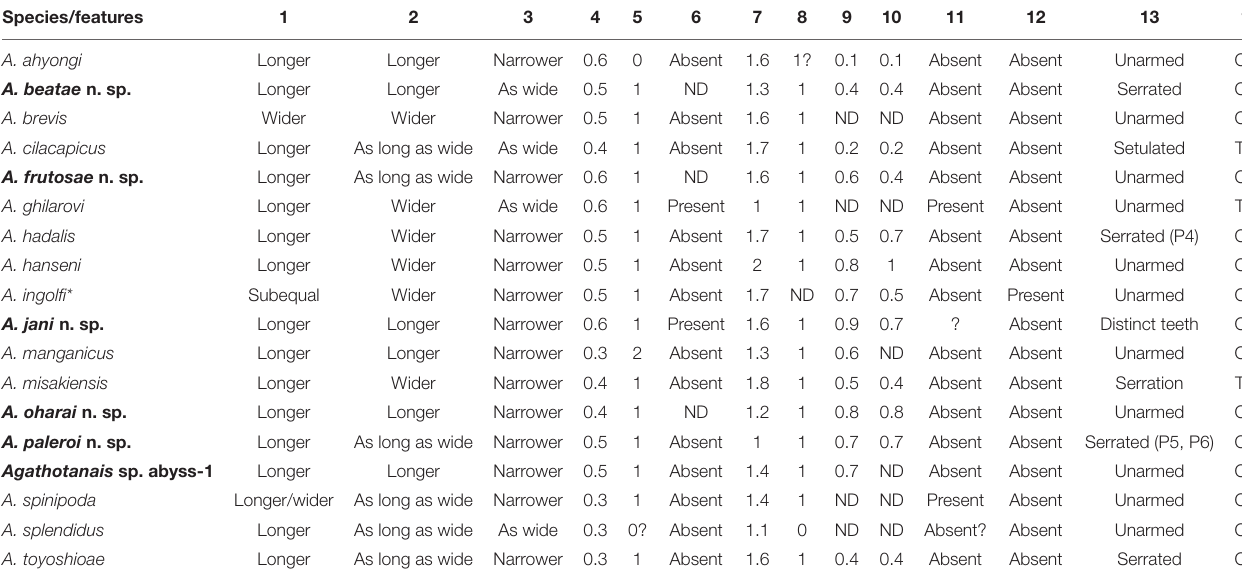
TABLE 1 | Diagnostic features distinguishing the species of Agathotanais : (1) Pereonites 4–5 L:W; (2) Pereonite-6 L:W; (3) Pleon: pereonite-6; (4) Antennule article-3:article-1; (5) Antenna numbers of articles; (6) Maxilliped endites distal denticles; (7) Cheliped palm L:W; (8) Fixed finger number of setae; (9) Pereopod-2 dorsodistal carpal seta: propodus length; (10) Pereopod-3 dorsodistal carpal seta length: propodus; (11) Pereopod-4 propodus row of small spines; (12) Pereopods 4–6 dactylus small accessory spine; (13) Pereopods 4–6 unguis ventral ornamentation; (14) Uropod endopod number of articles.